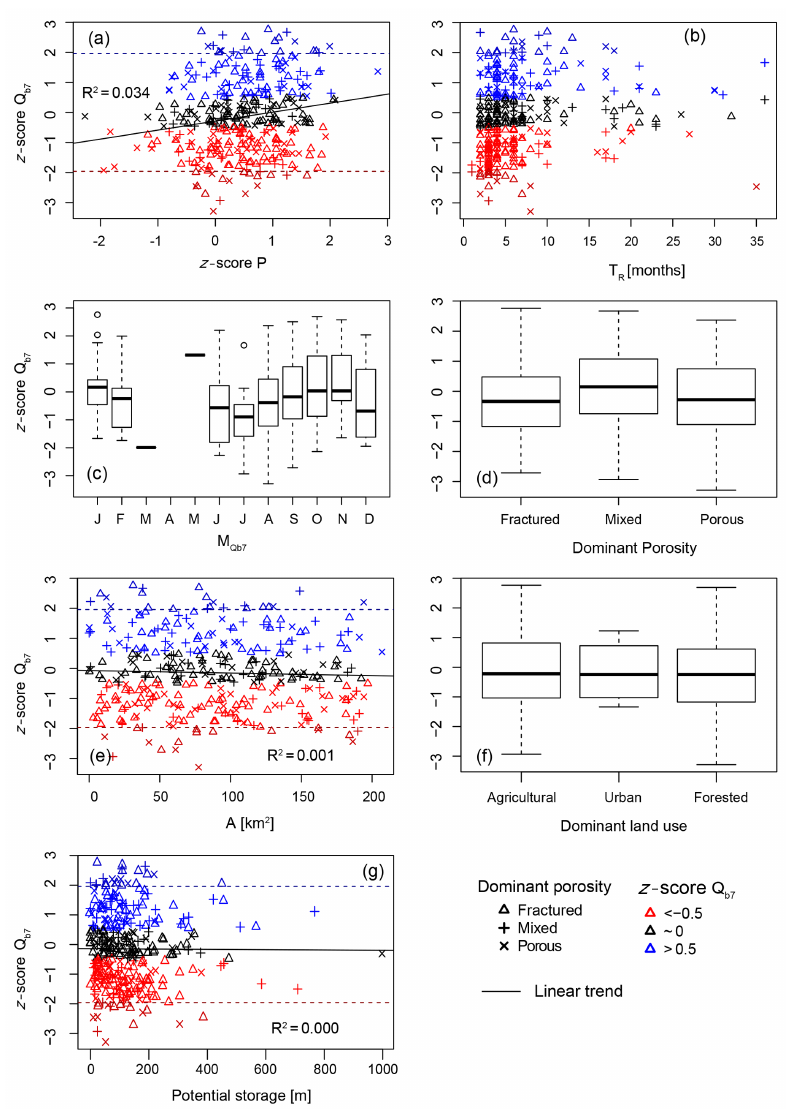
Figure 6. Attribution of trends in Q b7 to potential influencing factors. (a) Trends in precipitation P during the relevant recharge period, (b) length of response time T R , (c) M Q , (d) dominant porosity in the catchment (e) catchment size A , (f) dominant land use in the b7 catchment and (g) potential storage. Boxes represent the quartiles 0.25 and 0.75, and whiskers last to the most extreme value within a maximum distance of a 1.5-fold interquartile